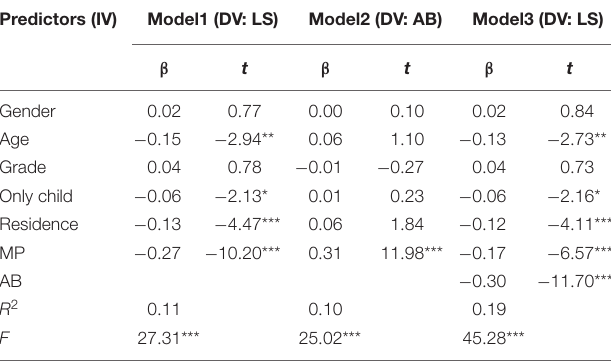
TABLE 2 | The mediation analysis. TABLE 3 | The moderated mediation